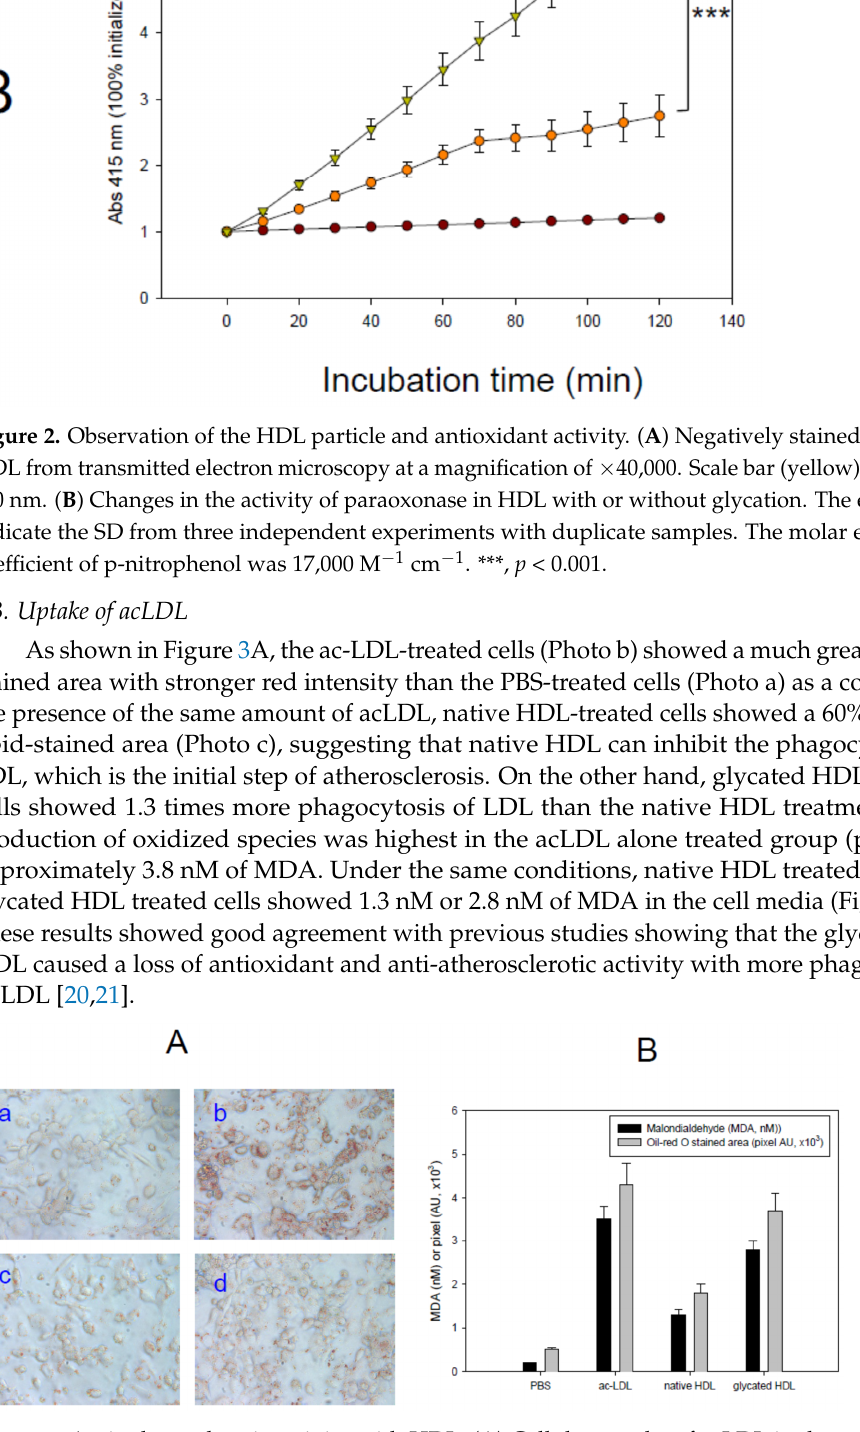
Figure 3. Anti-atherosclerotic activity with HDL. ( A ) Cellular uptake of acLDL in the presence of each HDL. Photo a, PBS alone; Photo b, acLDL-alone; Photo c, acLDL + native-HDL; Photo d, acLDL + glycated-HDL. ( B ) Determination of oxidized species in the cell media as a malondialdehyde standard. Oil-red O-stained cellular areas of 0.8 mm 2 were quantified using computer-assisted morphometry. Data are shown as the mean ± SD of three independent experiments performed in triplicate.